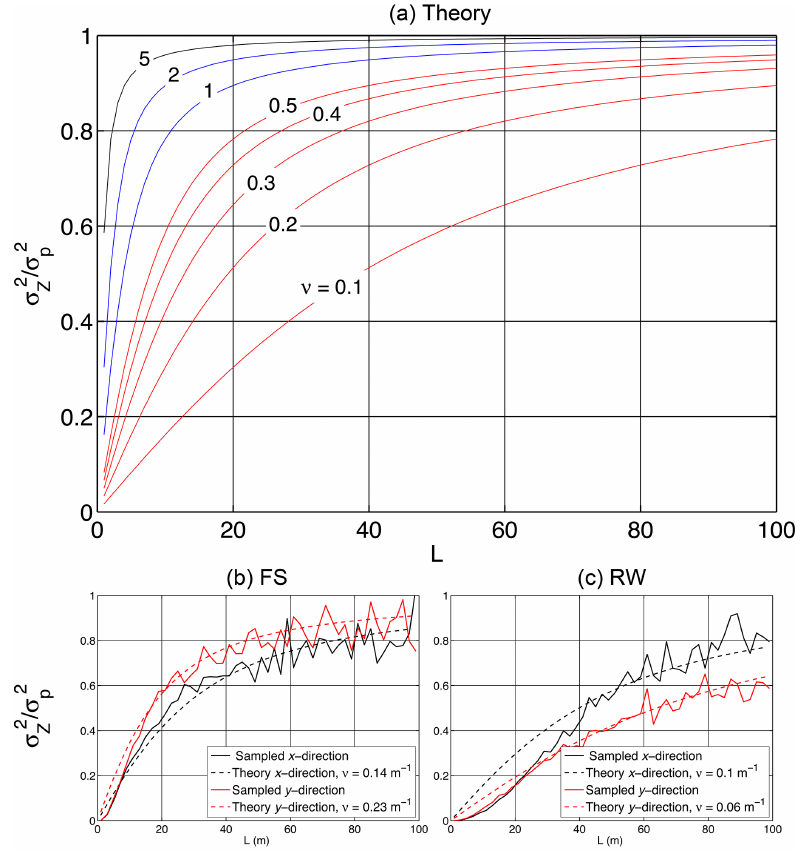
Figure 7. (a) Theoretical normalized squared error for a single measurement in the middle of a section of length, L , and for an exponential correlation function with a decay exponent, ν . (b) and (c) Comparison of the theoretical and sampled normalized squared error for the same survey case applied to profiles in FS and RW along the x and y directions. Dashed lines are the theoretical error from Eq. (7) using exponential decay exponents derived from the functions fitted to the sampled correlation functions of the two surfaces in the x and y